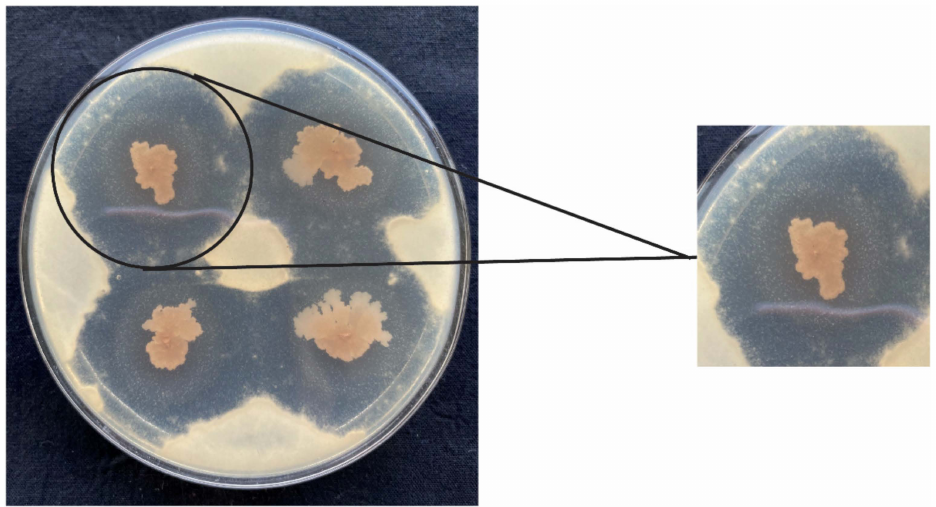
Figure 2. In vitro crosstalk assay between pathogen and Bacillus subtilis L1-21. The hollow zones around pink colonies display growth inhibition of pathogen by endophyte